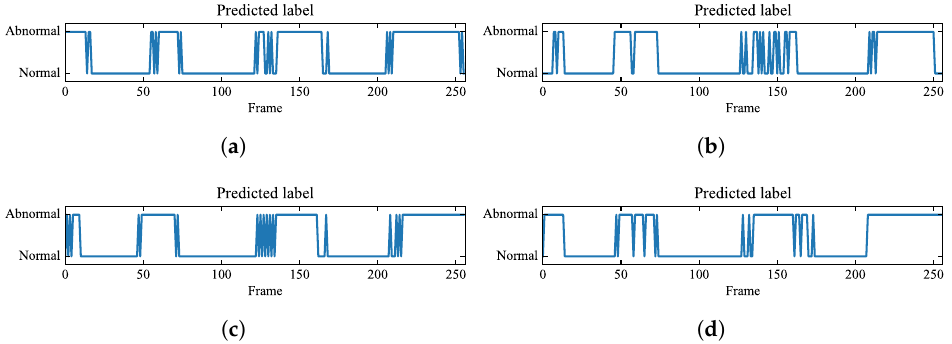
Figure 11. The frame-by-frame prediction results of the model when using different convolution kernel sizes for dilated convolution for the signal in Figure 10: ( a ) KS-3’s prediction label, ( b ) KS-5’s prediction label, ( c ) KS-7’s prediction label, ( d ) MKS’s prediction